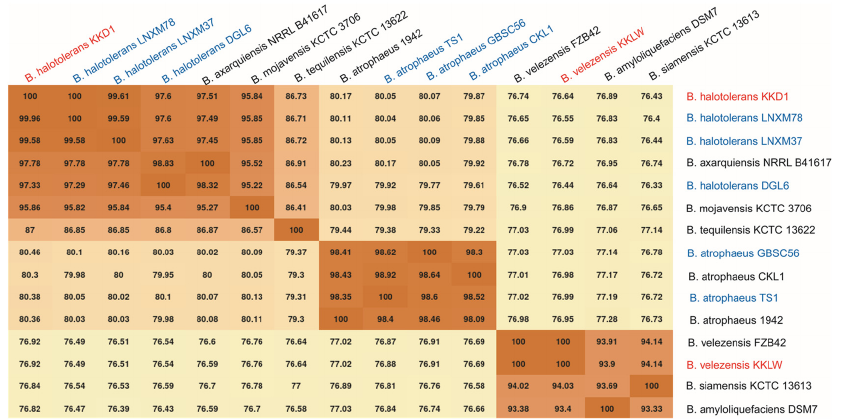
Figure 5. Heatmap of the ANIb matrix calculated for the genomes of B. halotolerans KKD1. Heatmap of the ANIb matrix calculated for the genomes of B. halotolerans KKD1 and closely related species. The method was based on a BLASTN com- parison of the genome sequences as described by Goris et al. [20]. B. halotolerans KKD1 is labelled in red letters. Strains isolated from the Qinghai–Tibetan plateau are labelled in blue letters.